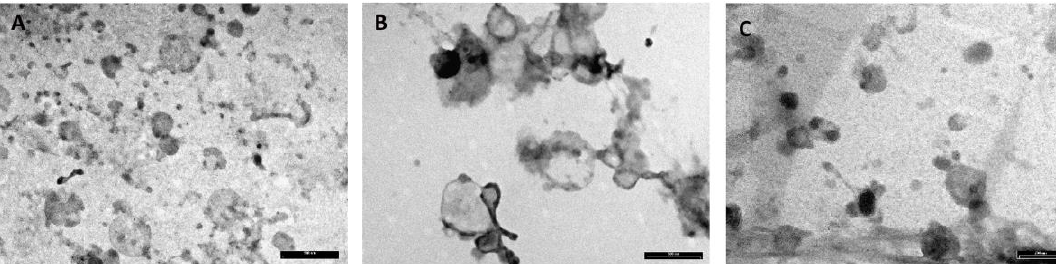
Figure 3. Electron micrograph showing MEVs isolated from donkey ( A ), bovine ( B ) and goat ( C ) milk. MEVs are round in shape and measure between 30 and 500 nm. Transmission electron microscopy (TEM), scale bar = 500 nm ( A , B ), 200 nm ( C ).